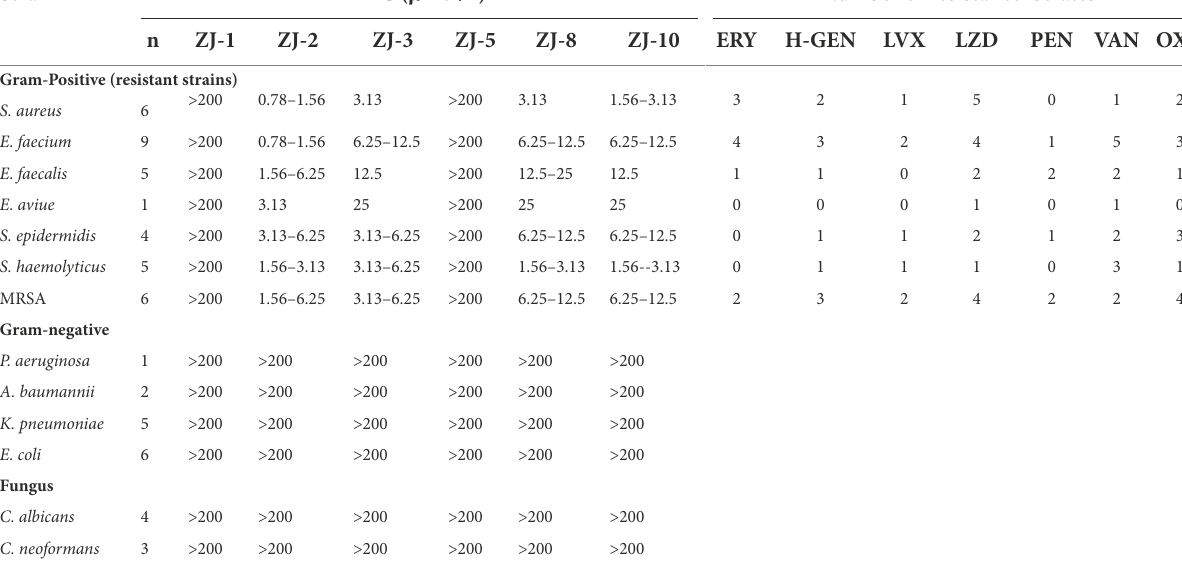
TABLE 1 MIC and antimicrobial susceptibility profiles of strains in this study. Strain